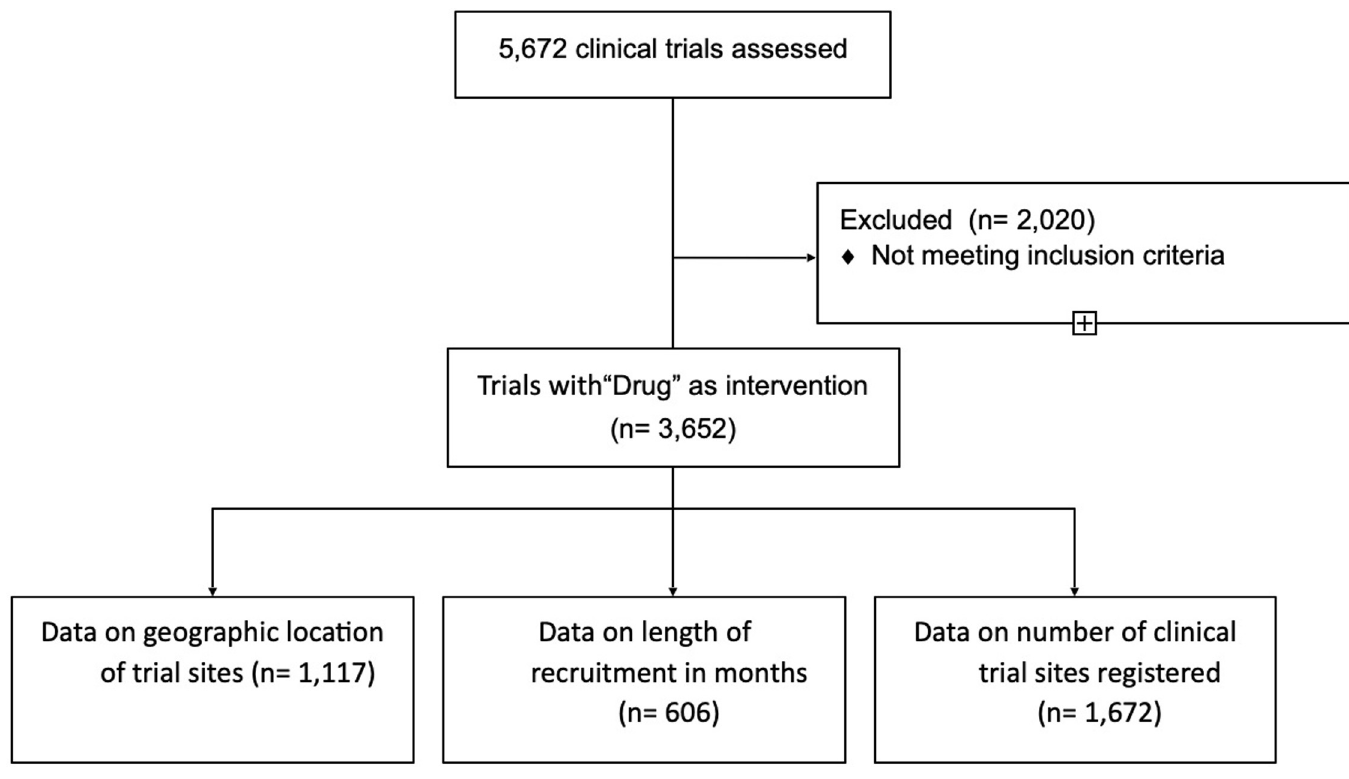
Fig 1. CONSORT flow